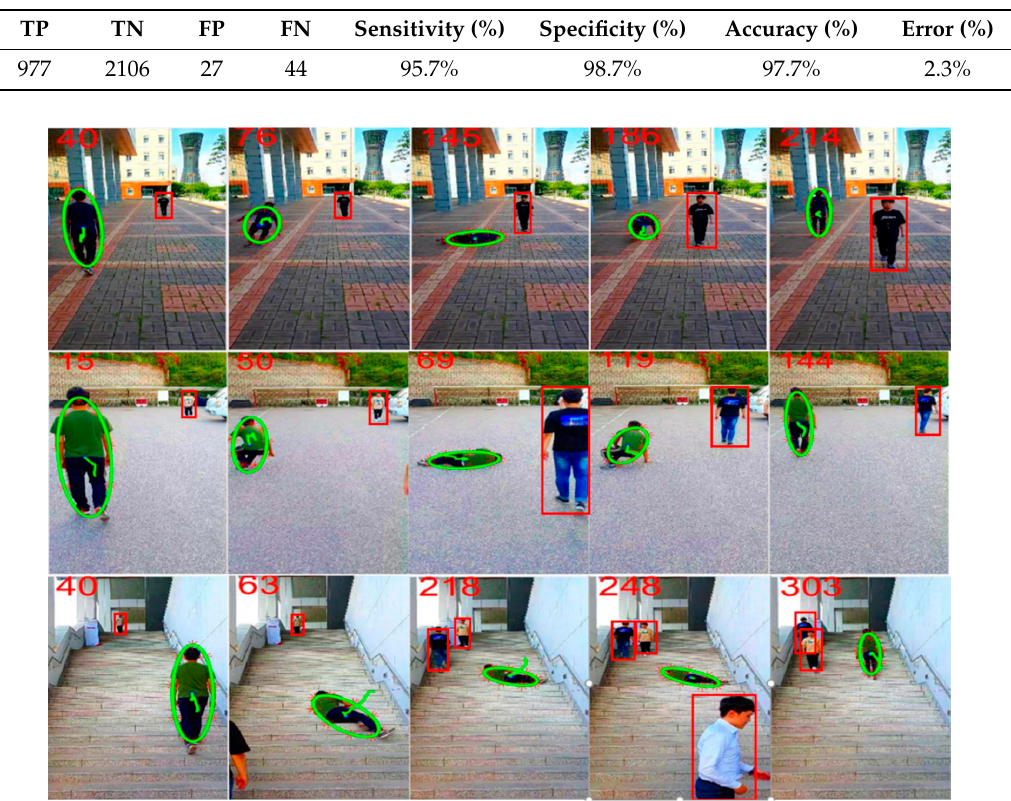
Table 3. Classification result of our system for all experiments.